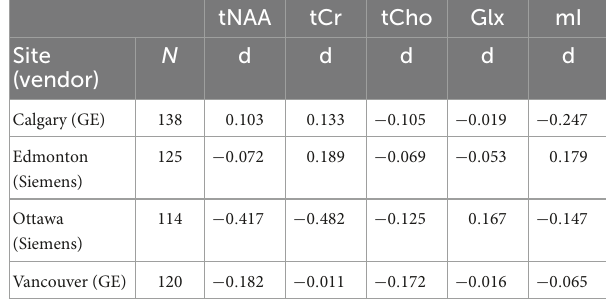
TABLE 1 Effect size estimates (Cohen’s d) of the comparison between concussion and orthopedic injury (OI) groups for each metabolite at the four largest sites (Calgary, Edmonton, Ottawa, Vancouver).